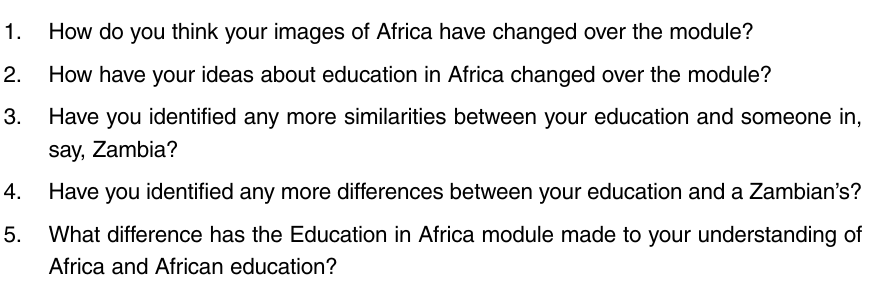
Table 2: End of module